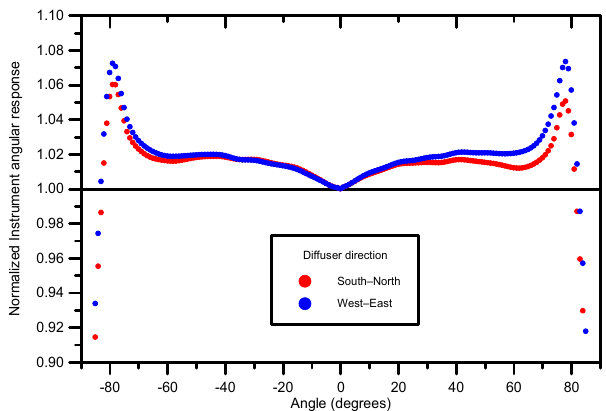
Figure 1. UVMFR angular response function at the 368nm chan- nel, normalized to the ideal (cosine) angular response. Two sets of responses, one from the south to north scan and one from the west to east, are